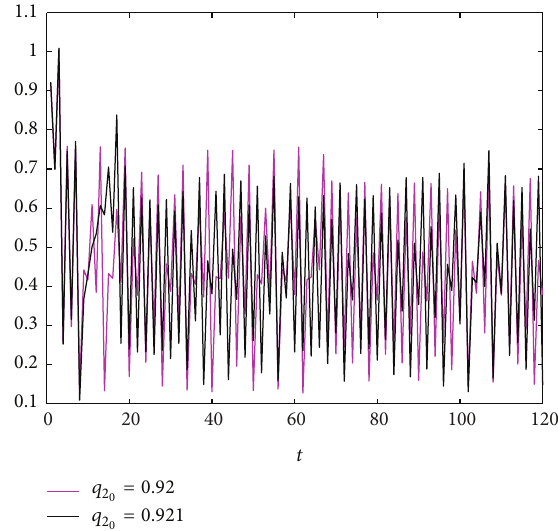
Figure 18: For 𝛼 1 = 2.05 , 𝛼 2 = 1.46 and 𝜃 = 0.5 , and the initial conditions which are (0.56, 0.92) and (0.561, 0.92), the history diagram with the change of time about the output 𝑞 1 .